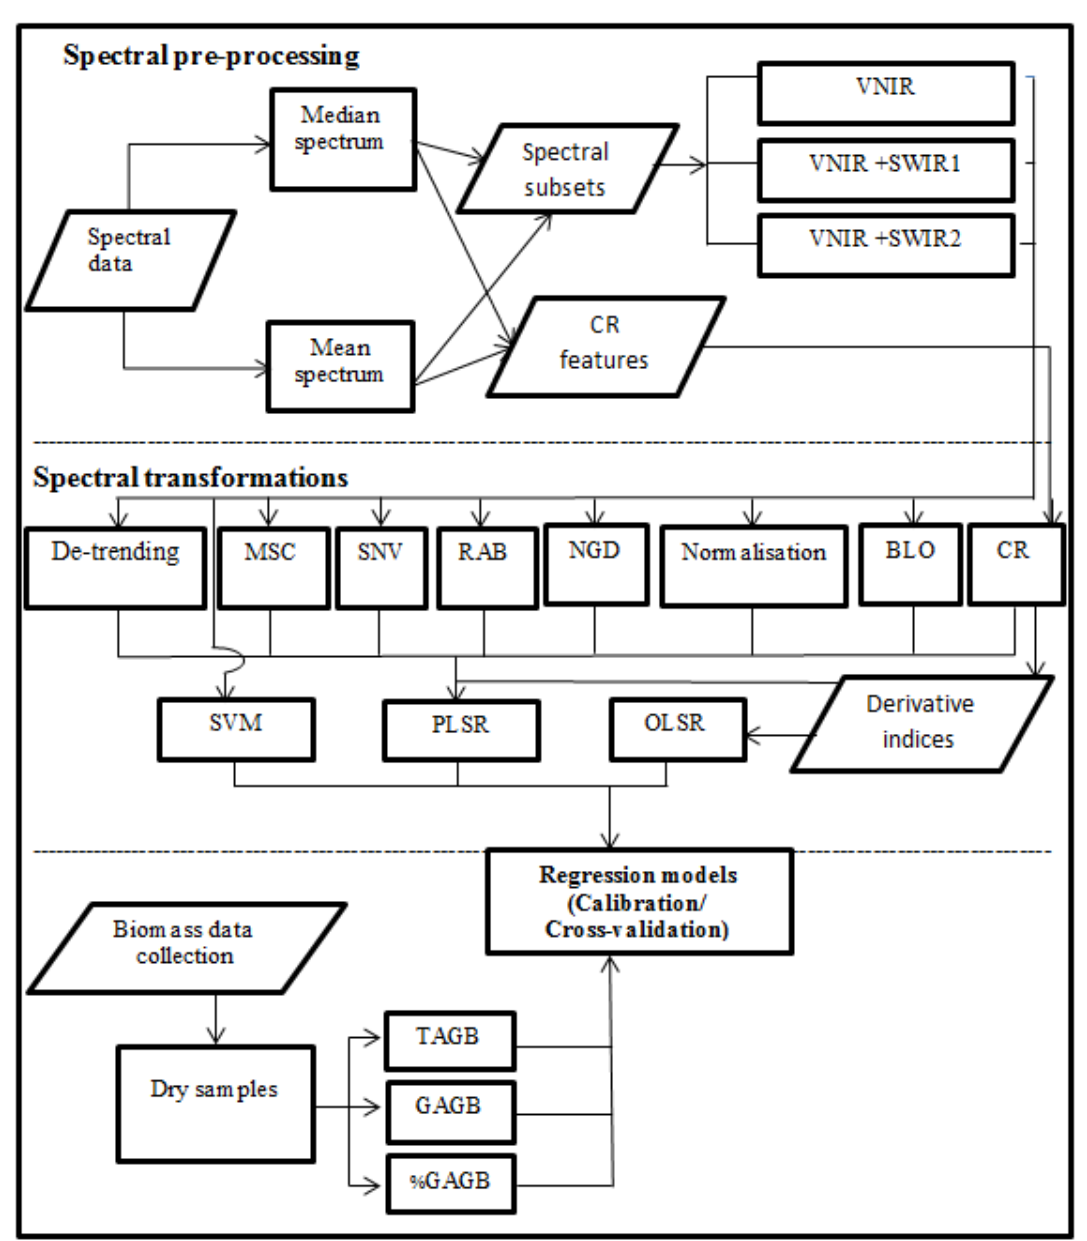
Figure 2. Methodology flowchart.